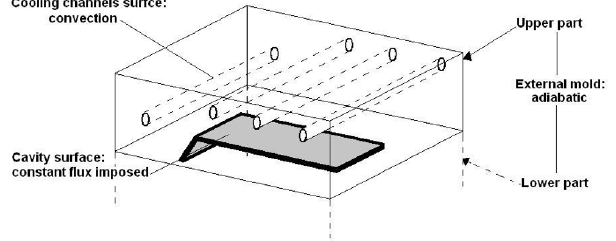
Fig. 3. Boundary conditions. Table 1. Parameter values for heat-transfer